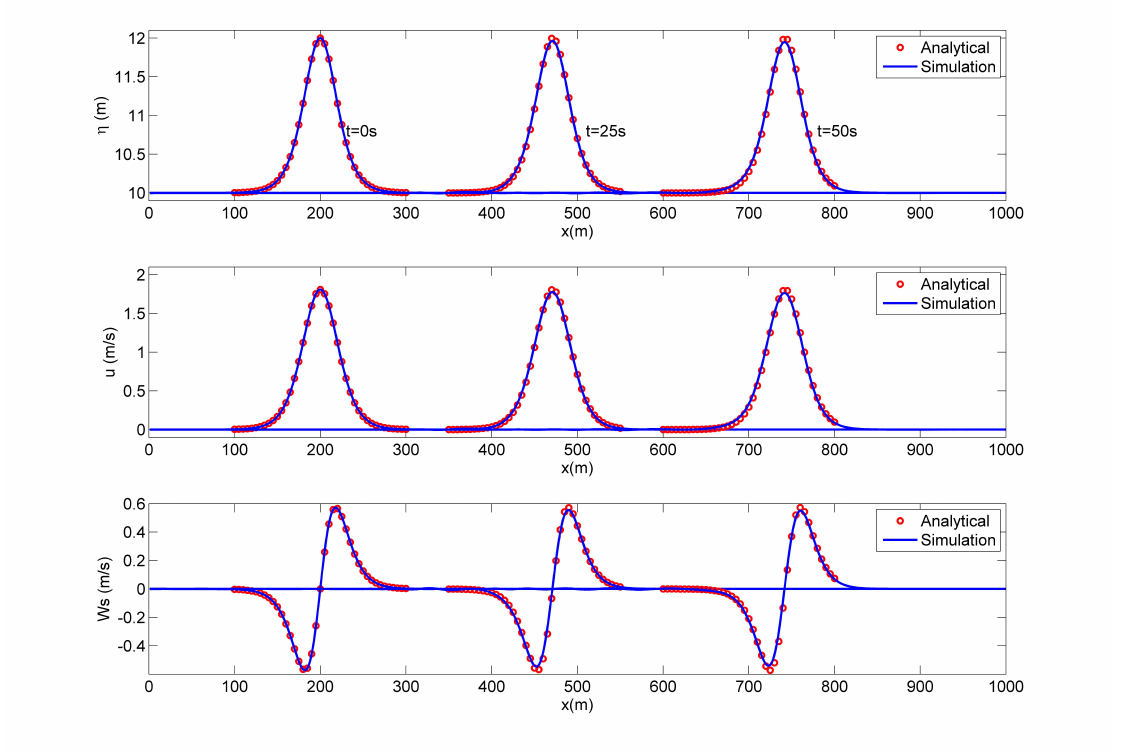
Figure 3. Comparisons between simulated results and analytic solutions at t = 0, 25 and 50 s for solitary wave propagation in constant depth.